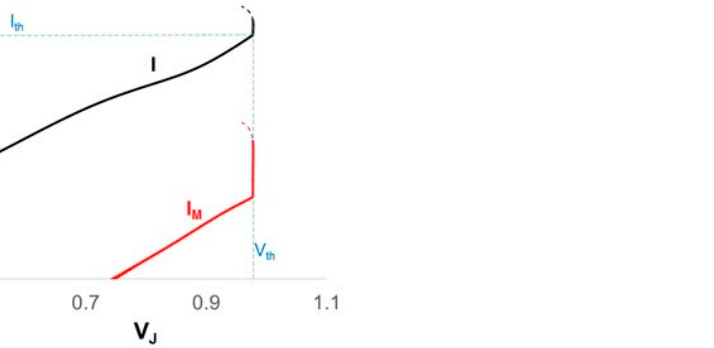
Figure 19. Laser current I and monitor current I M as functions of the internal voltage V J for the laser of Section 4.